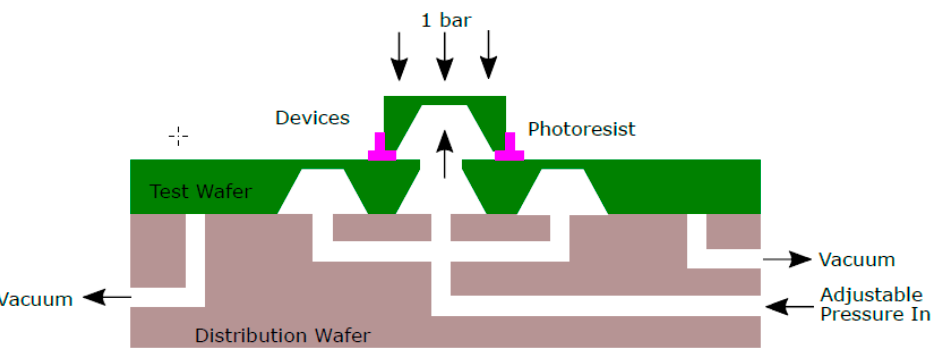
Figure 5. A cross-sectional drawing of the set-up for the threshold pressure